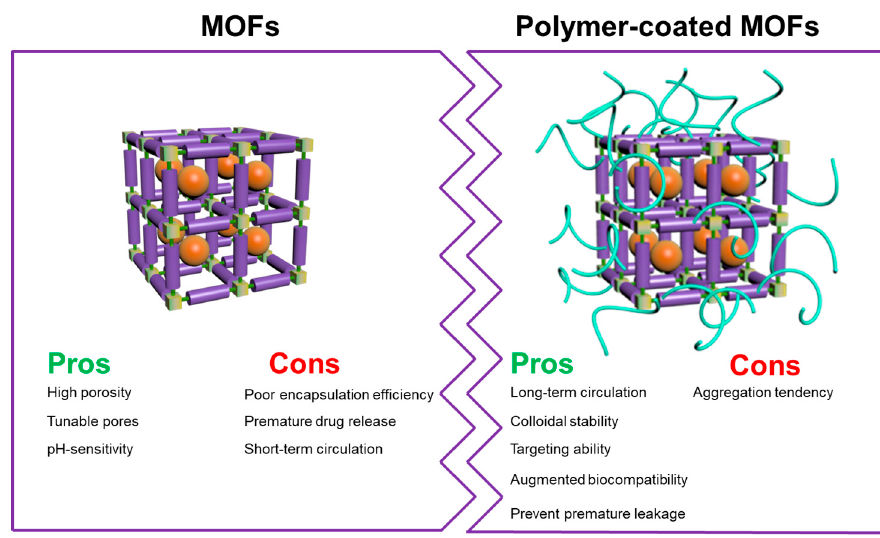
Figure 1. Schematic illustration the combination of polymer and MOF and their pros and